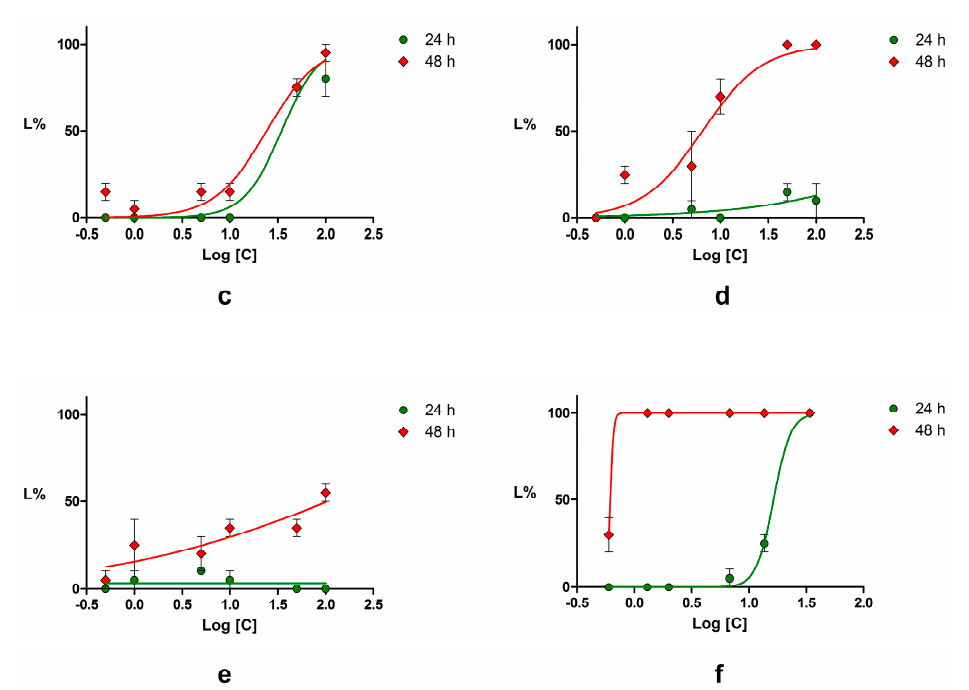
Figure 9. Daphnia magna lethality—logarithm of concentration curves at 24 and 48 h for: ( a ) piperine; ( b ) chrysin; ( c ) emodin; ( d ) podophyllotoxin; ( e ) umbelliferone; ( f ) potassium dichromate. Error bars represent standard error of the mean.